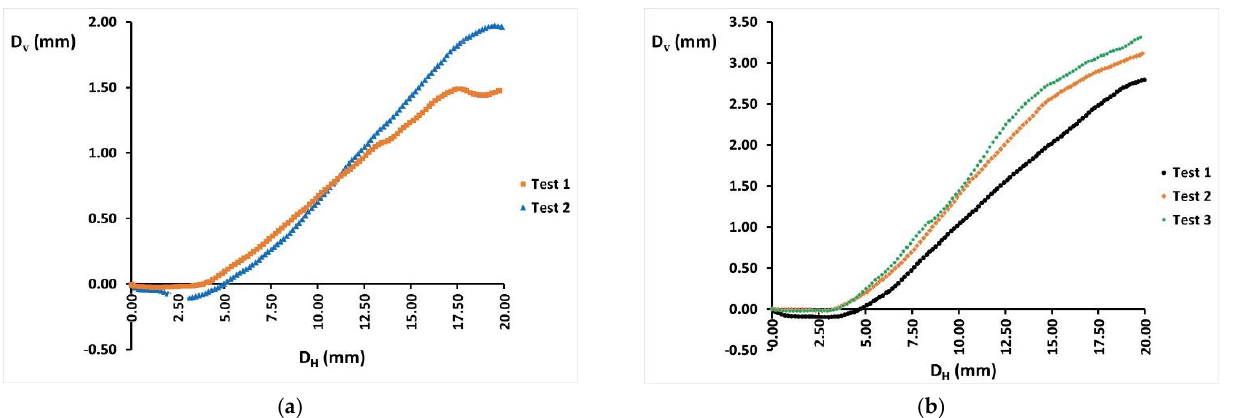
Figure 9. Deformation curves for the wood pellets at ( a ) 100 kPa normal stress and ( b ) 20 kPa normal stress.